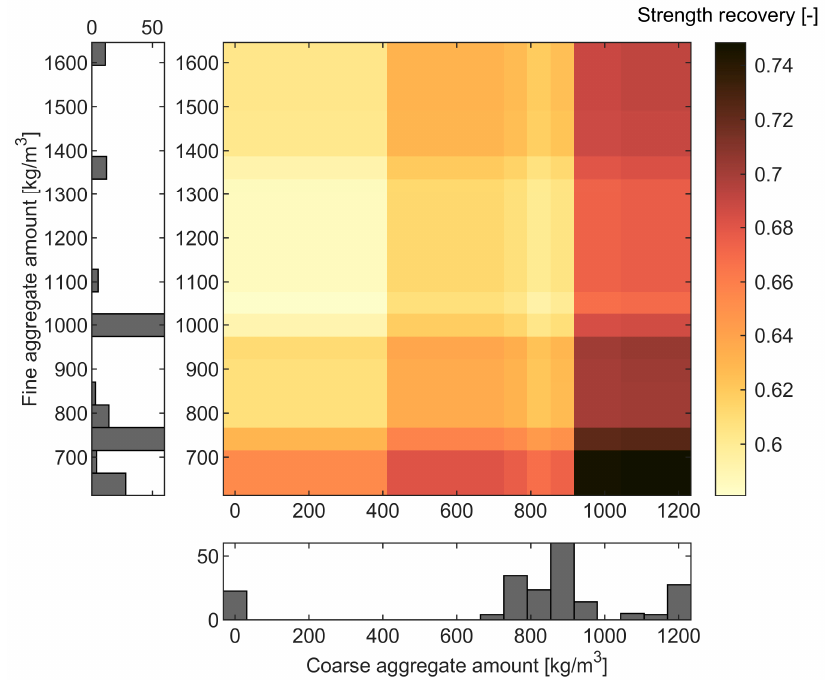
Figure 11. Heatmap PDP for the two variables: coarse and fine aggregate vs. strength recovery. Colors correspond to different values of strength recovery.